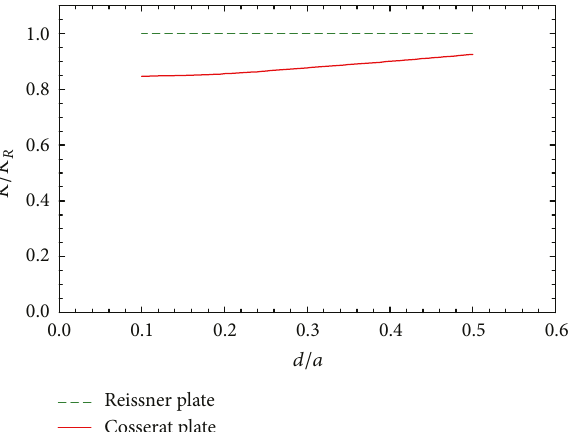
Figure 14: Comparison of the ratios of the stress concentration factor of the Cosserat plate 𝐾 with the stress concentration factor of the Reissner plate 𝐾 𝑅 for different hole sizes. Smaller holes exhibit less stress concentration than what would be expected on the basis of Reissner